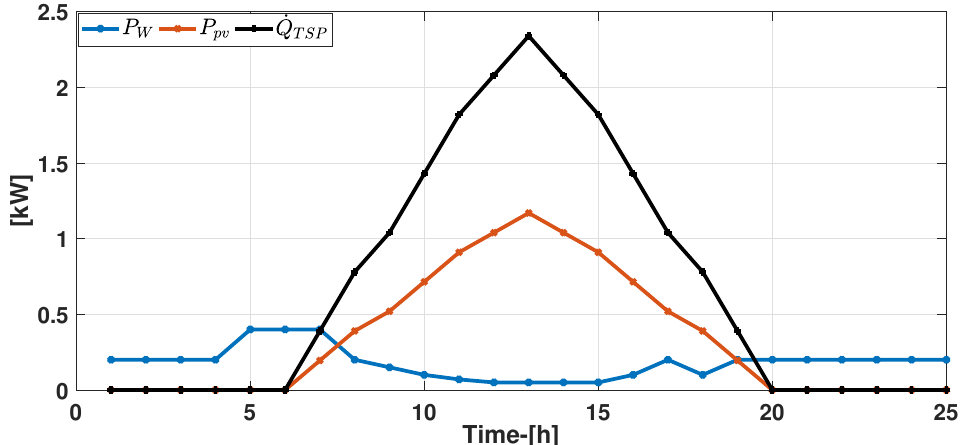
Figure 6. Thermal and electric power